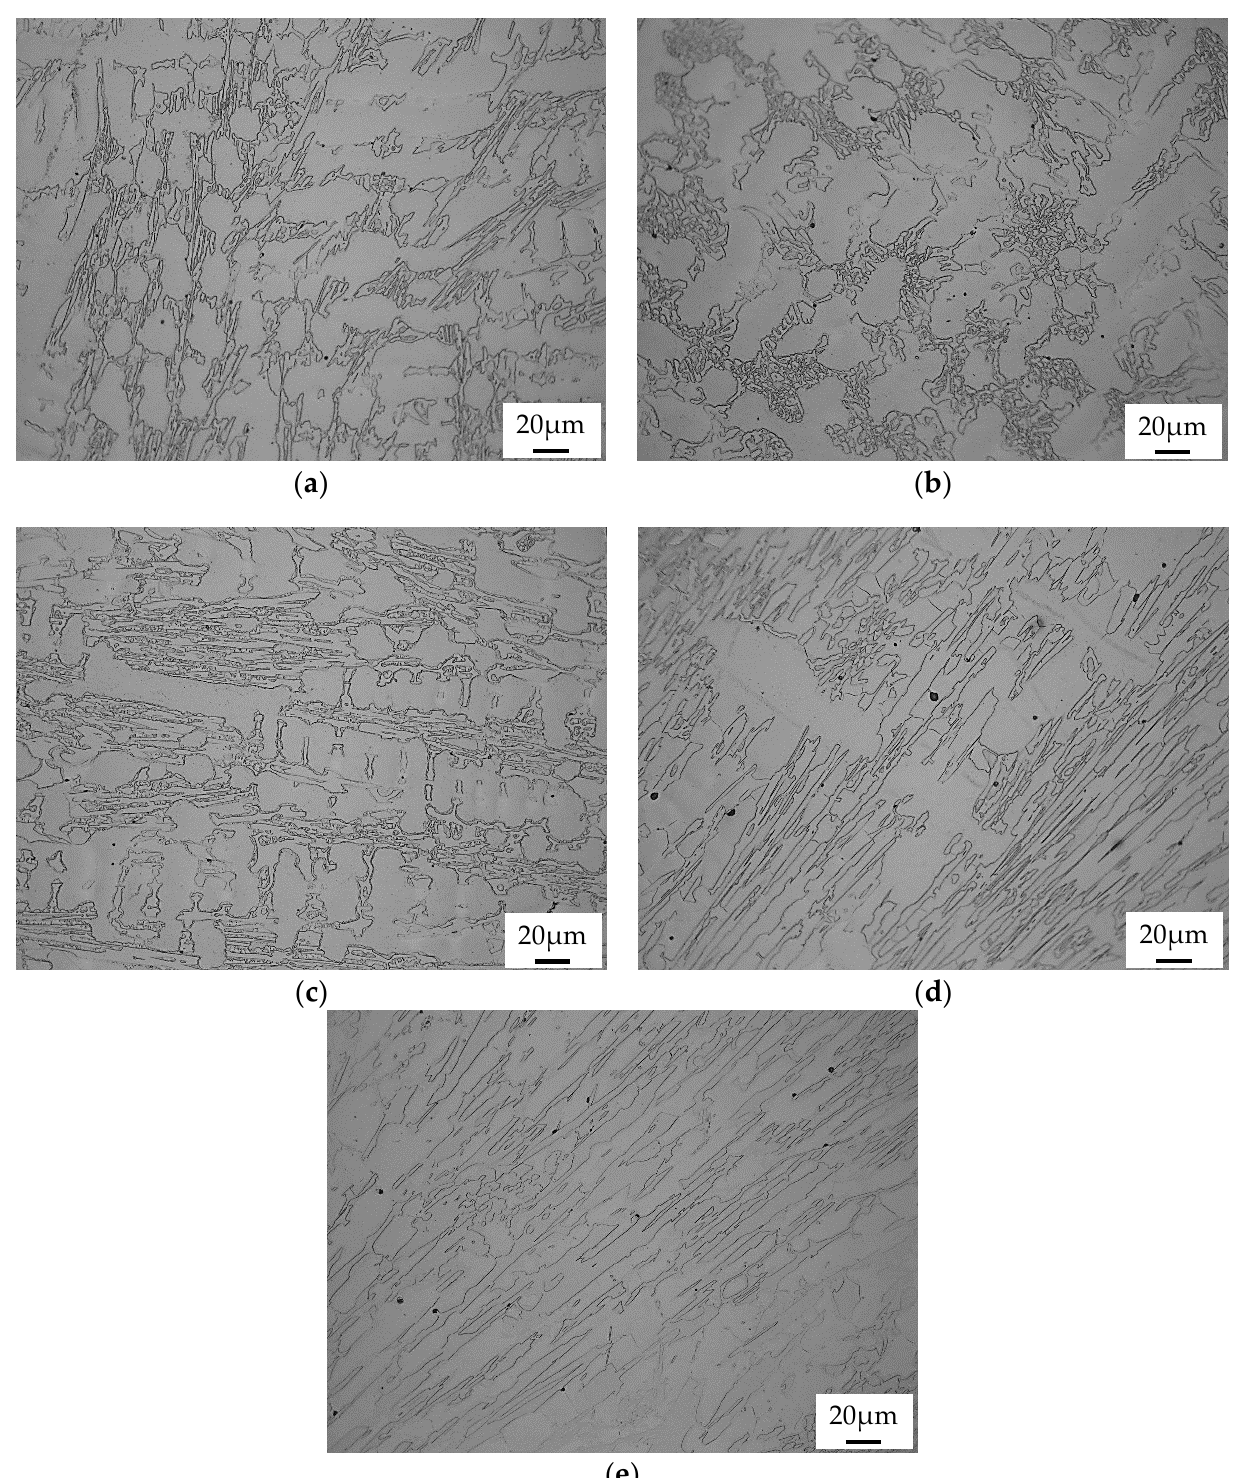
Figure 2. Optical micrographs of the as-cast alloys showing various dendrite fractions: ( a ) 2124; ( b ) 2127; ( c ) 2427; ( d ) 2827; ( e ) 2927.